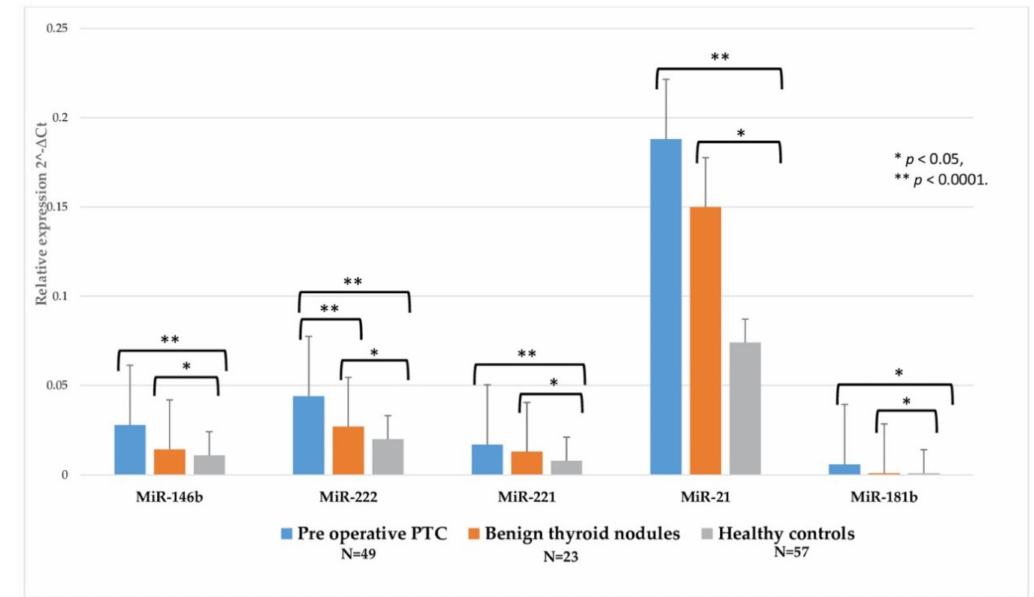
Figure 4. The comparison of plasma miRNA expression between papillary thyroid cancer (PTC), nodular goiter patients and healthy control groups. All data are presented as the mean ± SD. * p < 0.05, ** p <